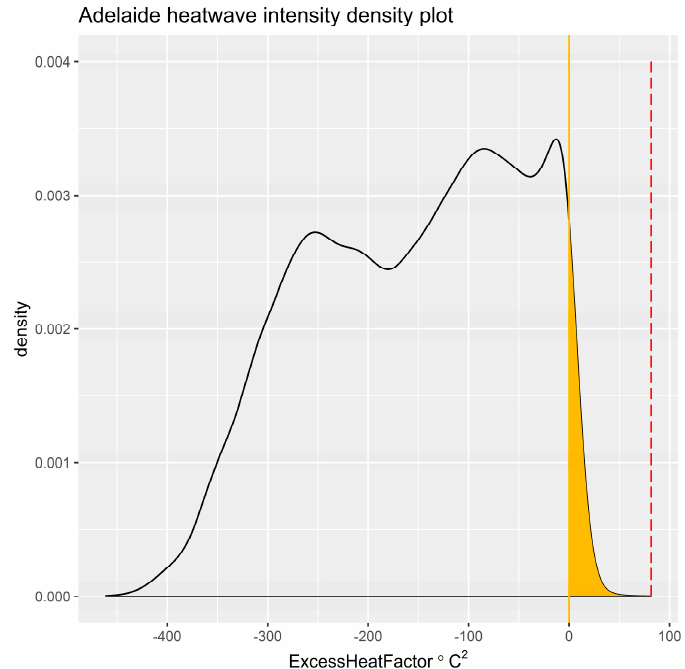
Figure A6. Distribution function of EHF for period 1887 to 2018. Values greater than zero shown in yellow are heatwaves. Maximum EHF value in distribution is indicated by dashed red line.